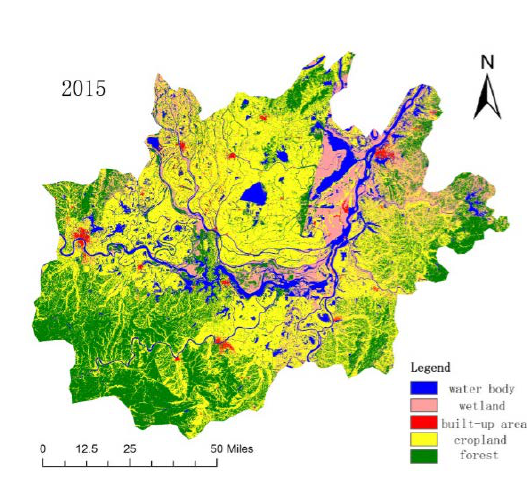
Figure 3. LULC map of Dongting Lake area in 2015